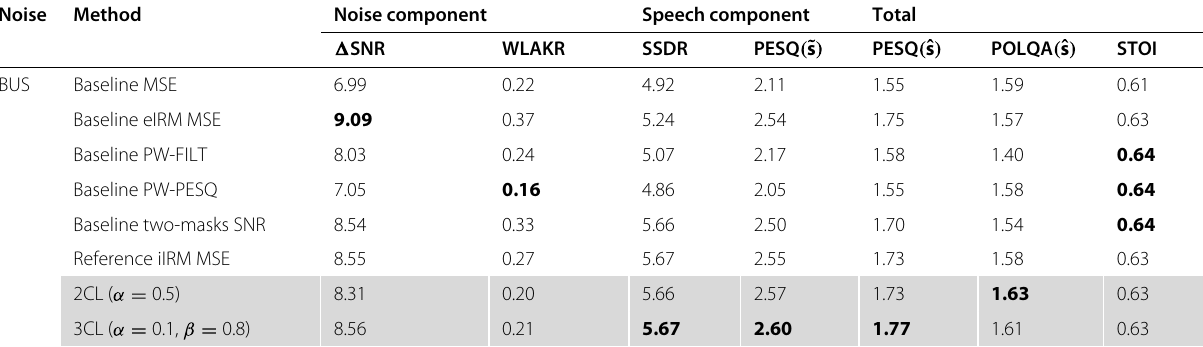
Table 9 Performance for unseen noise (BUS) on the test set ; SNR 5 dB . Best approaches from Tables 1 and 3 are gray-shaded; the best scheme is in boldface